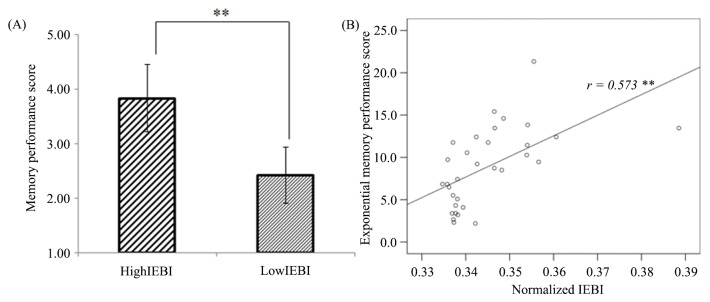
Relationship between IEBI and memory recall after one month.(A) Memory performance for High-IEBI and Low-IEBI scenes. (B) Correlation between normalized IEBI value and memory performance score (**: p< 0.01, Fig 4B and S4 Dataset).